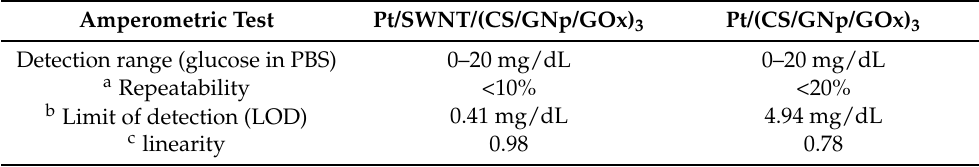
Table 2. A comparison between sensors immobilized with and without single-walled carbon